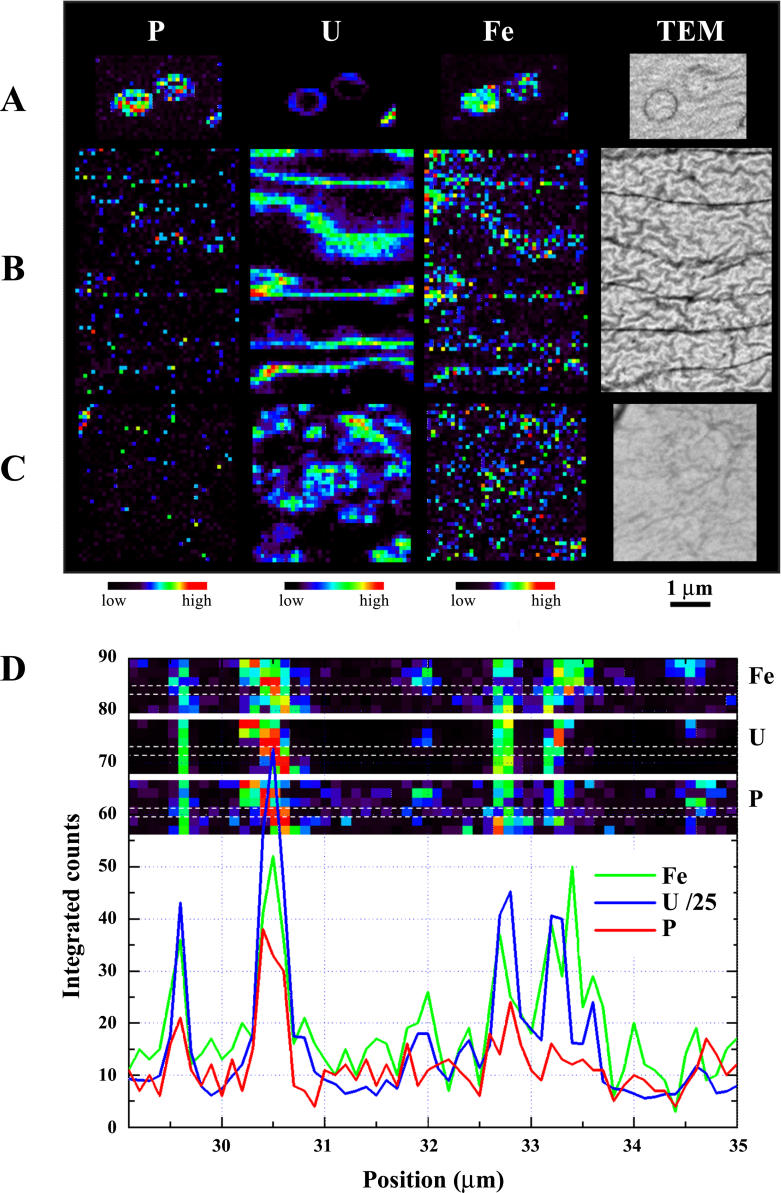
Synchrotron XRF Microscopy of the Elemental Concentration Gradients in Association with
S. oneidensis MR-1 Cells
False-color micro-XRF maps of qualitative spatial distributions and concentration gradients of P, U, and Fe in and around MR-1 cells. Cells are shown after incubation with 250 μM U(VI) for 24 h in standard assay conditions (A). The extracellular UO
2 precipitates associated with EPS (B) and diffuse extracellular UO
2 nanoparticles (C) observed in MR-1 samples were also evaluated for elemental composition. The scanned regions are represented with each corresponding thin-section TEM image. (D) The UO
2-EPS features seen in (B) were scanned vertically six times longer per point, and the pixel intensity (identified between the dashed lines) was plotted for each element. Although this image is of a smaller area and has a smaller number of features in its field of view, the increased measurement time provides more robust statistics and further supports co-localization of the elements.